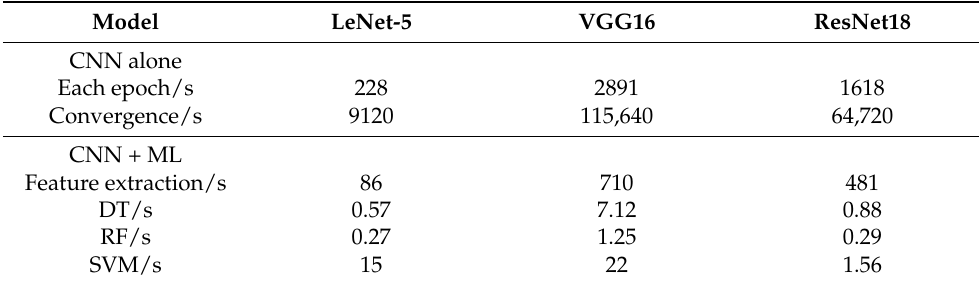
Table 4. Time of training CNNs and machine learning classifiers.